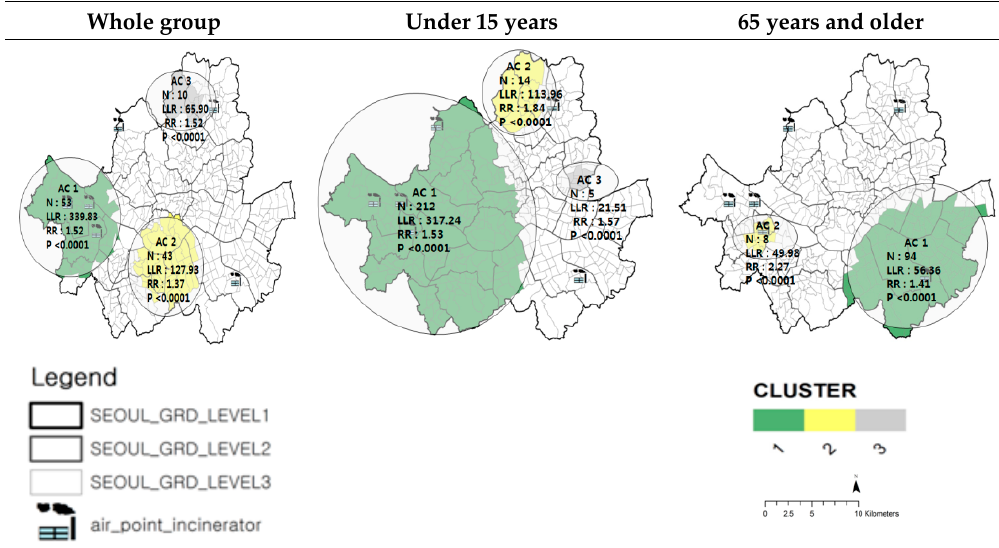
Figure 3. Clustered Areas of Asthma-related Admission by Age, Seoul (2009–2011).